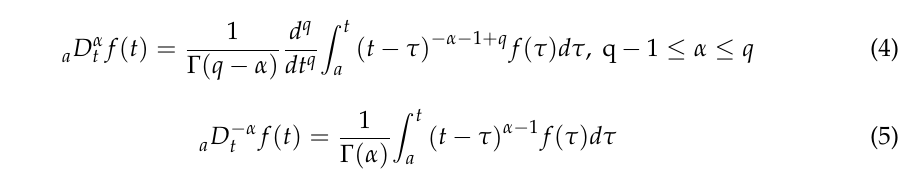
quency bias constant ( B i ); Δ f 1 and Δ f 2 are the deviation in area frequency; Δ P tie and a 12 are deviation in tie-line power flow and area rating ratio, respectively.